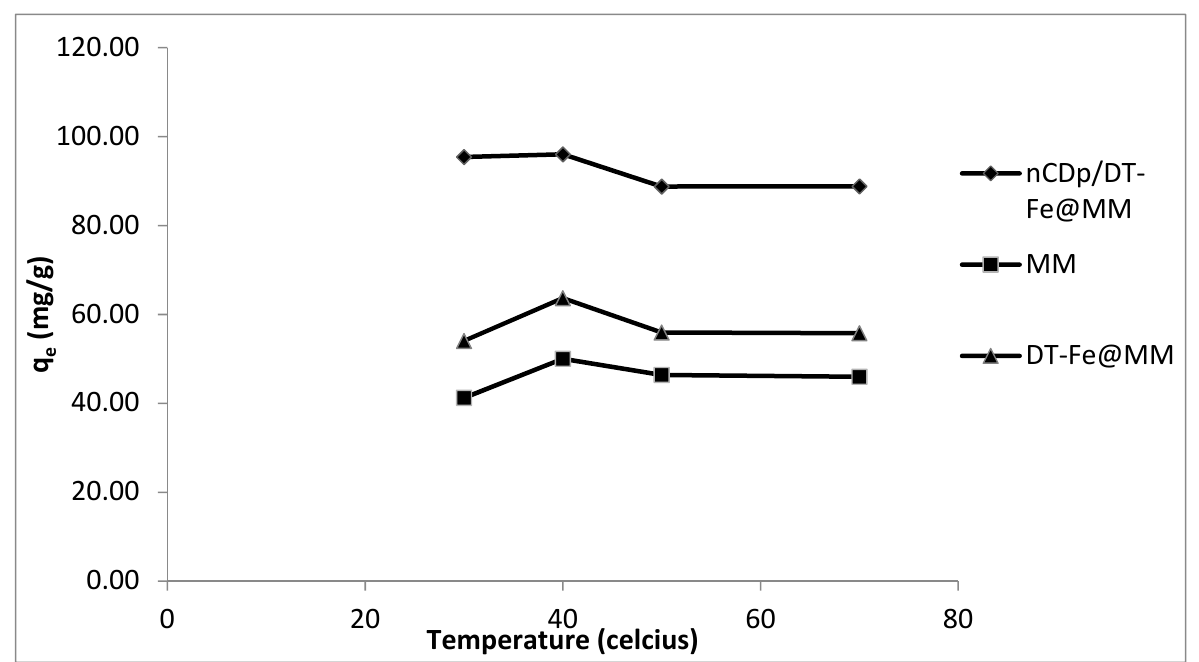
Figure 14. Effect of temperature on the removal of BPA. (Adsorption conditions: C o = 50 mg/L; dos age = 0.02 g/L; t = 120 min; pH = 8).